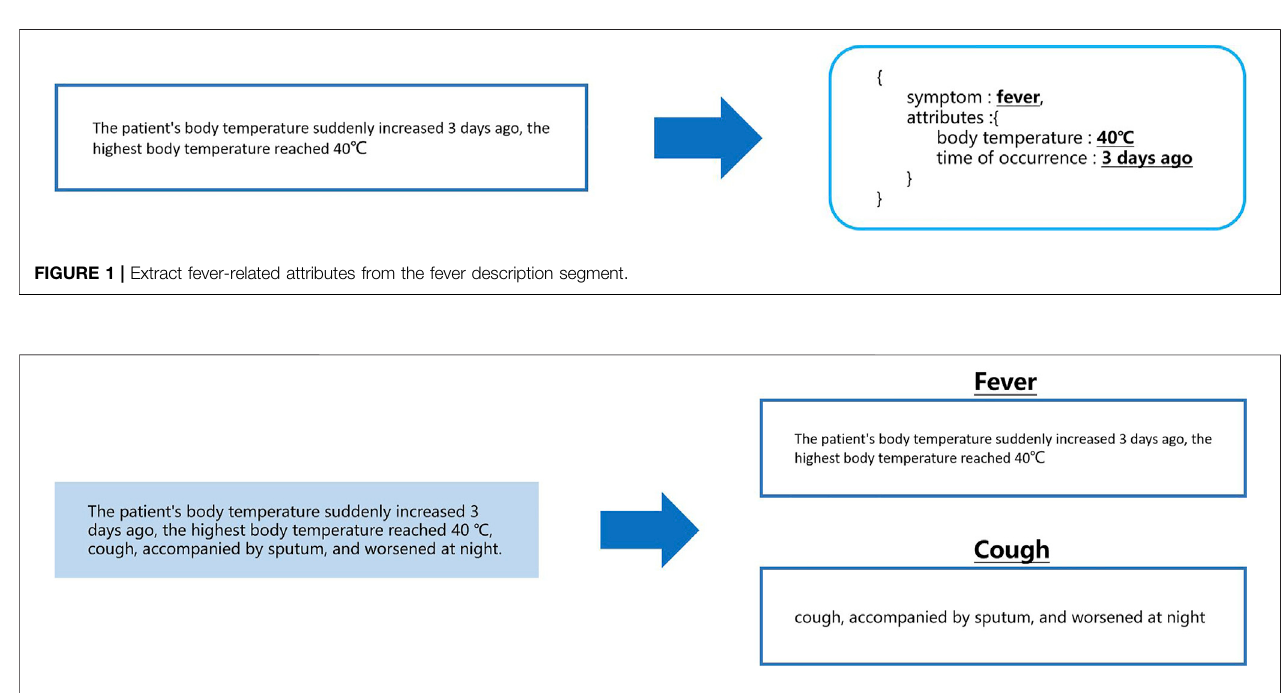
FIGURE 2 | From a sentence describing symptoms, separately extract segments describing fever and cough.